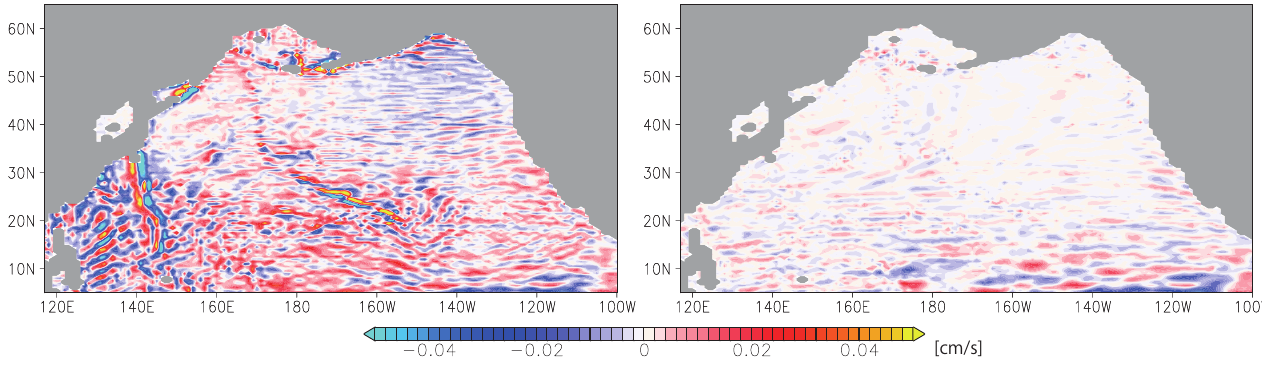
Fig. 10. Vertical velocity w [cm s − 1 ] at 1900 m depth in the North Pacific in (a) TIDE and (b) NOTIDE. The instantaneous distributions at the end of the 40-day experiment are shown.